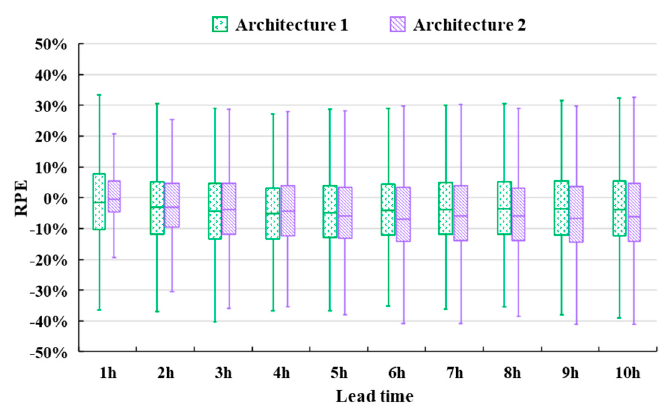
Figure 15. RPE for different model architectures at 1–10 ‐ h lead ‐ time.